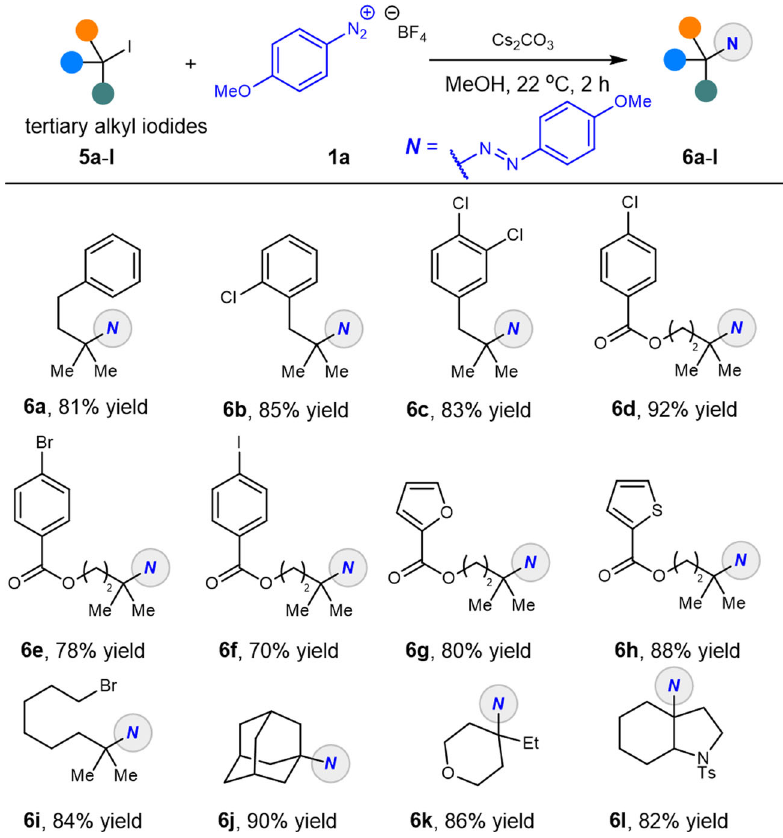
Fig.4|Substratescopeoftertiaryiodides. Reactionconditions: 1a (1.5mmol,3.0equiv), 6a – l (0.5mmol,1.0equiv),andCs 2 CO 3 (0.75mmol,1.5equiv)inMeOH(5.0mL) at 22°C for 2h. Isolated